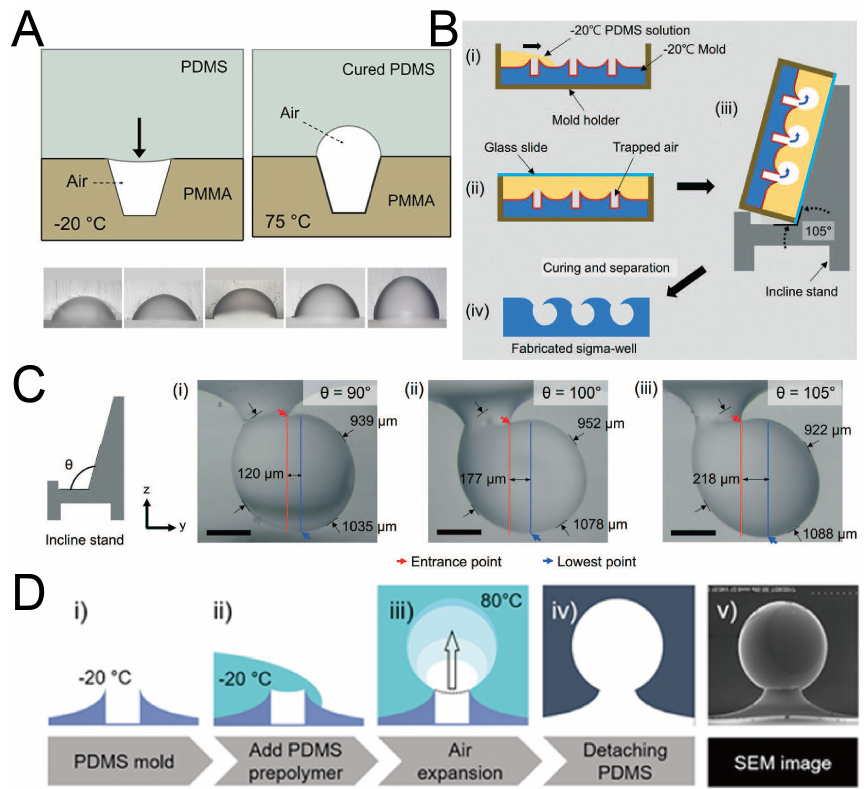
Figure 6. Replica molding of air bubbles. ( A ) Micro-cavities were fabricated on a PMMA base, and PDMS was poured on it. With heating, the volume of air bubbles increased and PDMS cured at the same time [60]. Reprinted (adapted) from [60]. Copyright (2012) with permission from AIP Publishing. ( B ) Low-temperature PDMS was poured onto a volcanic mountain-like PDMS mold, and placed on an inclined stand. Air bubbles expanded and PDMS cured at the same time to form Sigma-shaped microwells [62]. ( C ) Pictures of Sigma-shaped microwells using inclined stands of different angles [62]. Scale bar: 350 µm. Reprinted (adapted) from [62]. Copyright (2021) with permission from Royal Society of Chemistry. ( D ) The procedures of fabrication of Omega-shaped microwells (i–iv), and an SEM image of a microwell (v) [61]. Reprinted (adapted) from [61]. Copyright (2018) with permission from IOP